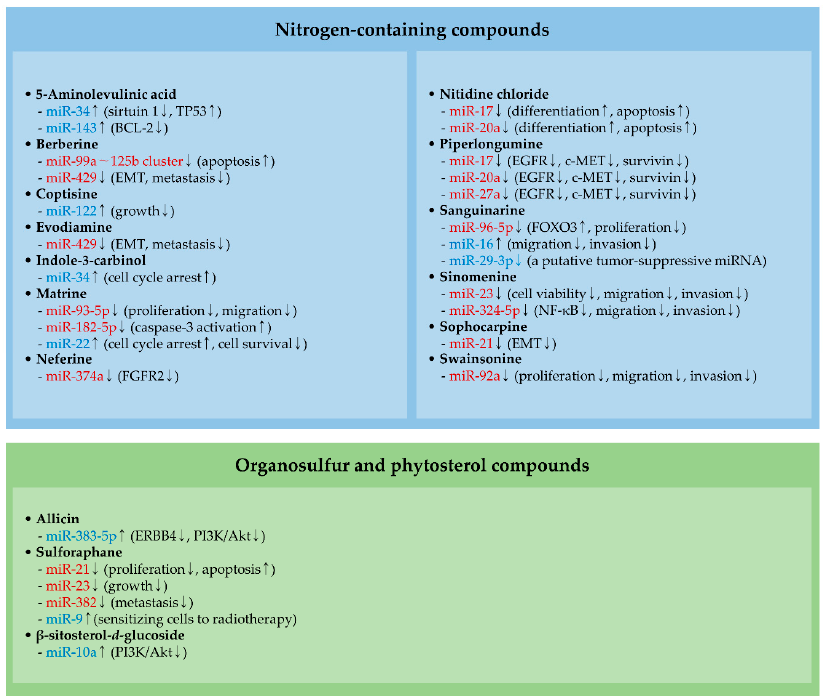
Figure 1. Effects of nitrogen-containing compounds and organosulfur/phytosterol compounds on the expression level of oncogenic miRNAs (red) and tumor-suppressive miRNAs (blue). Arrows indicate the upregulation ( ↑ ) and downregulation ( ↓ ) of miRNA levels and consequential effects on cancer. The role of miRNAs in cancer therapy with phytochemicals is described in Sections 2 and 3. Table 3. Oncogenic miRNAs downregulated by phytochemicals in cancer. Effective in Vivo Dose Effective in Vitro of Phytochemical in Concentration of miRNA Phytochemical (A Type of Cancer) Mouse Models of Ref. Phytochemical/Treatmen Cancers (A Route of t Time Administration)